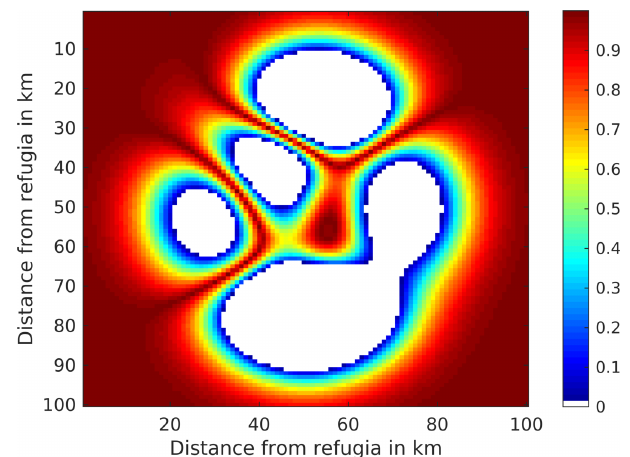
Figure 2. Seed dispersal permeability for SMSM simulation tests. Each time the seed matrix is shifted, the probability of entering the new cell (which in our test is set to 5 × 10 − 7 ) is multiplied with the seed dispersal permeability of the new potentially entered cell. A permeability value of 1 indicates that the landscape is not hindering the species-specific seed dispersal, while a value of 0 indicates that the landscape completely blocks any seed